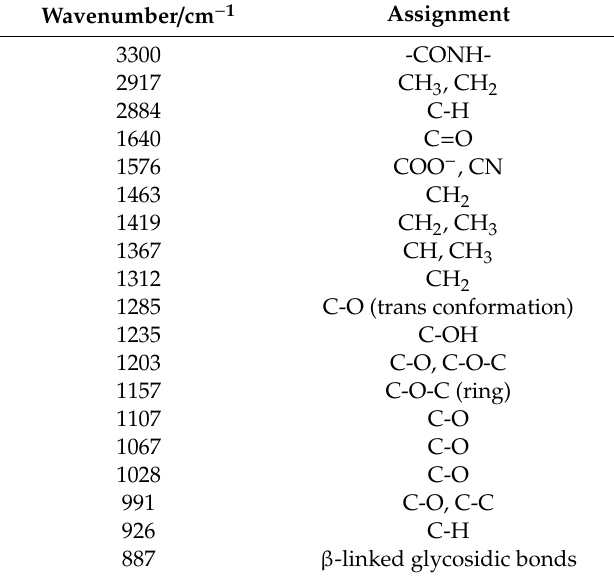
Table 1. The most important bands obtained in the FT-IR spectra of 1,3- β -D-glucan [29,30].